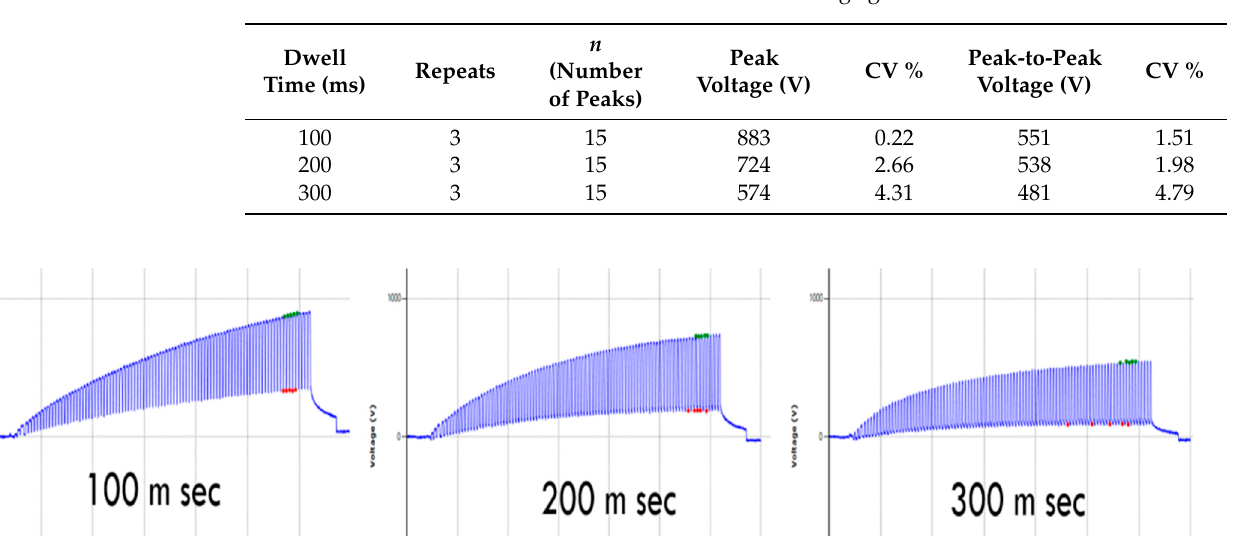
Figure 11. Effect of dwell time on the electrostatic waveform.